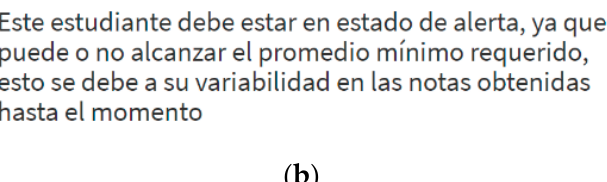
Figure 6. ( a ) The analysis of a student’s individual performance is displayed. ( b ) An x is placed according to the analysis, showing the student’s performance in the context of risk acceptability matrix, with consideration given to the standard deviation of grades obtained to date vs. the cumulative performance average.